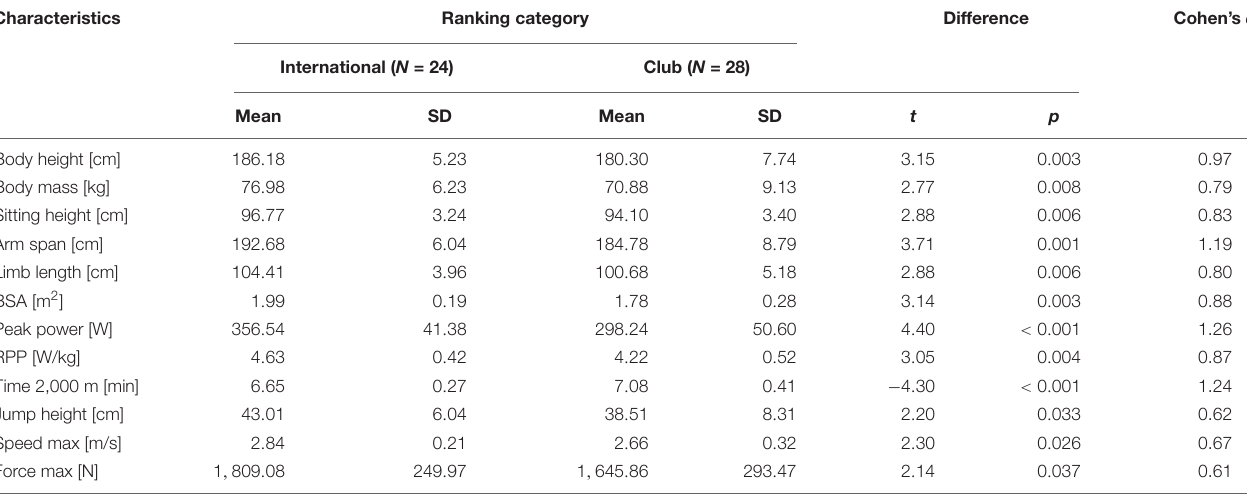
TABLE 2 | Comparison of arithmetic means of older junior male rowers anthropometric, physiological and motoric parameters depending on the ranking categories.